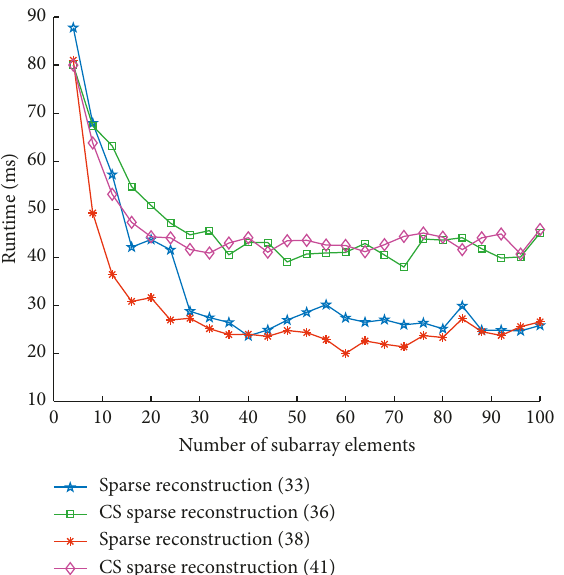
Figure 8: Runtime vs. the number of subarray elements for sparse reconstruction methods with and without CS